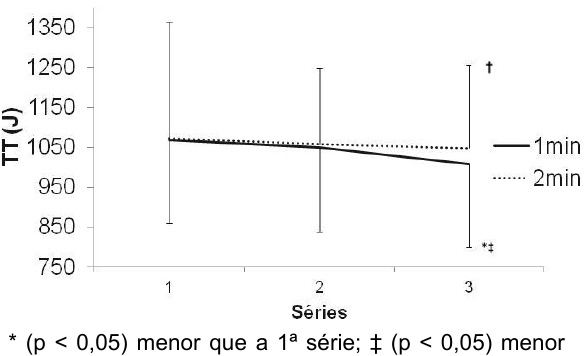
Figura 4. Trabalho Total (TT) a 180°/s nas três séries com 1 e 2min de intervalo de